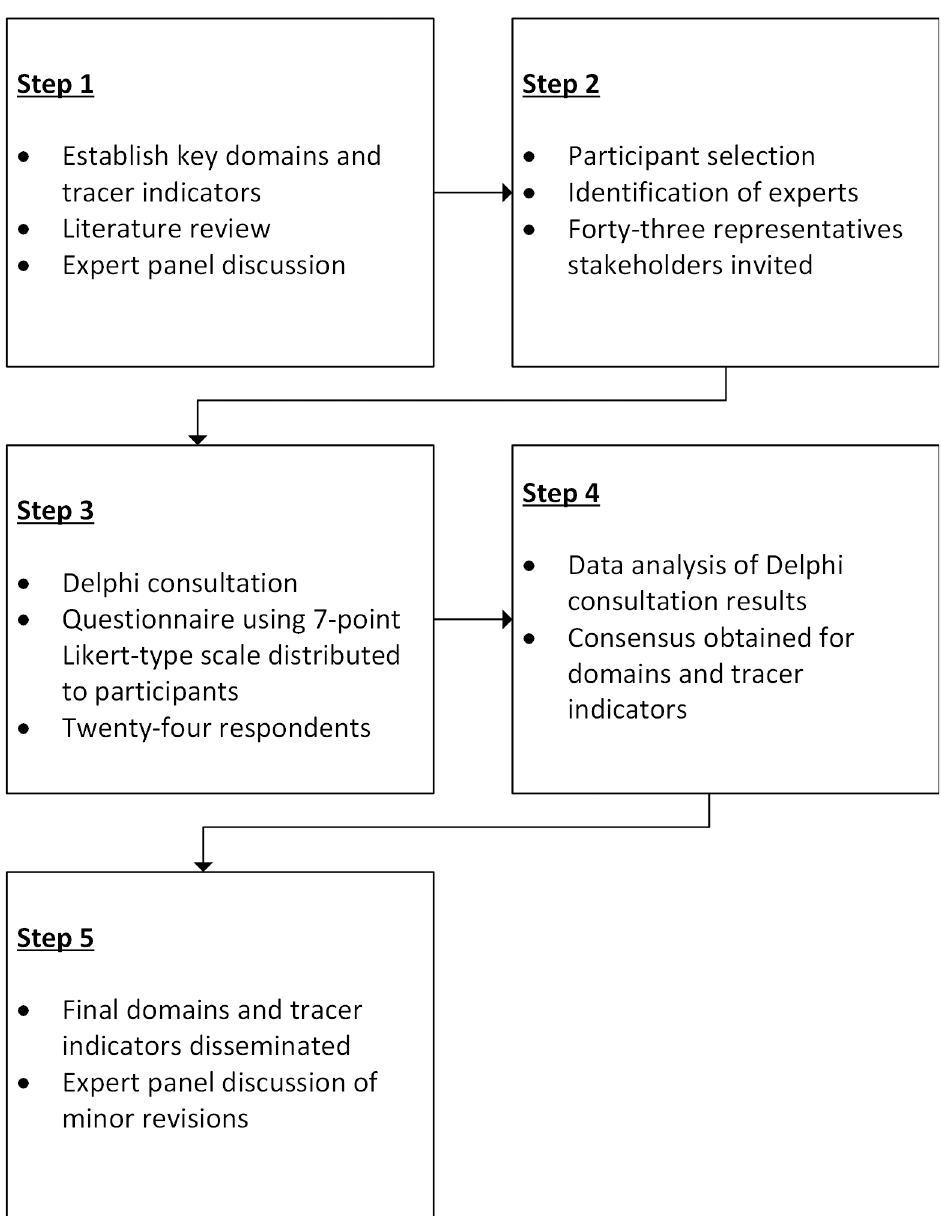
Fig 1. Process of selection of domains and indicators to determine readiness of health facilities to provide quality lymphoedema management services.